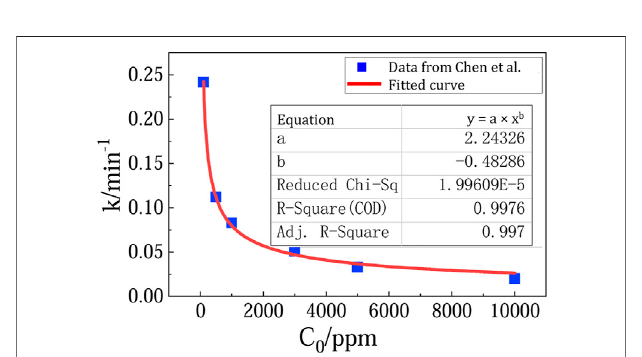
FIGURE 4 | Fitting curve of C 0 and k from experimental